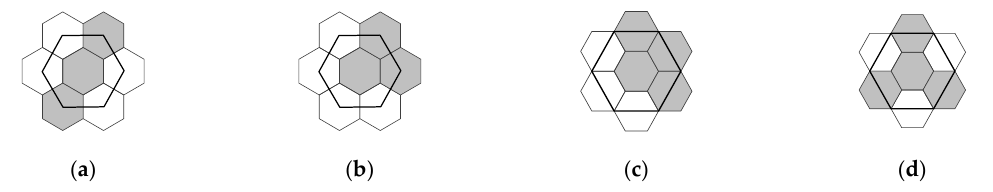
Figure 6. Types of child cells generated to ensure the uniqueness of indexing: ( a ) and ( b ) are for aperture 3; ( c ) and ( d ) are for aperture 4. The gray cells are the chosen child cells of the parent cell (source—partly refer to [13]).